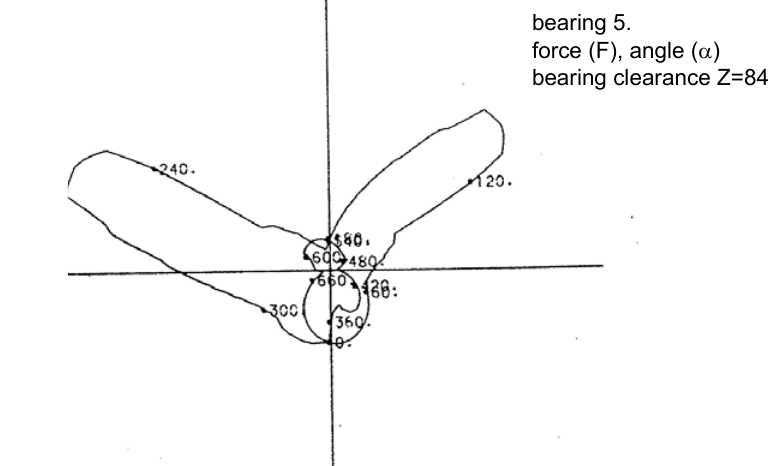
Figure 4 – Polar load diagram of the main sleeve of the 5th bearing depending on the angle of rotation of the engine crankshaft, bearing clearance Z = 84 